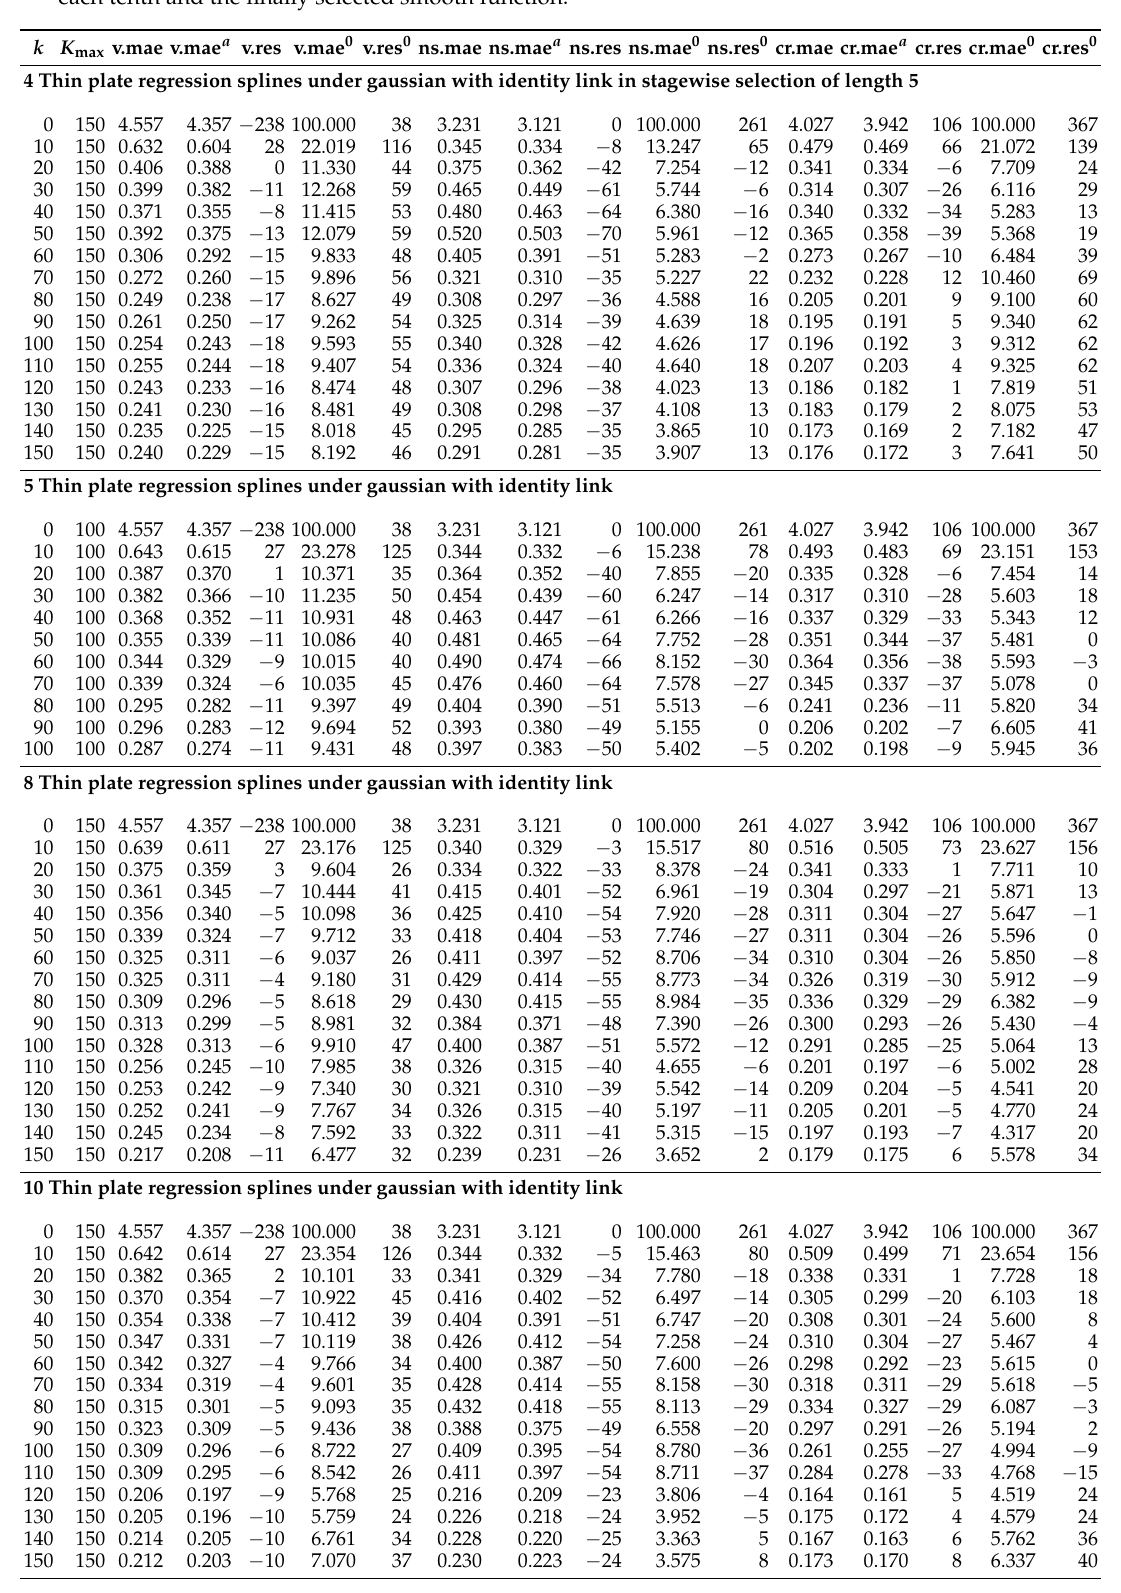
Table A15. Out-of-sample validation figures of selected generalized additive models (GAMs) of BEL with varying spline function number per dimension and fixed spline function type under 150–443 after each tenth and the finally selected smooth